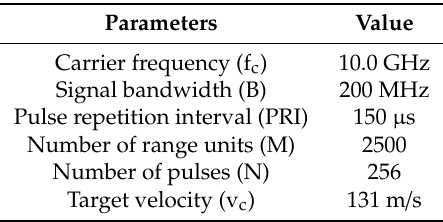
Table 3. Experiment parameters.